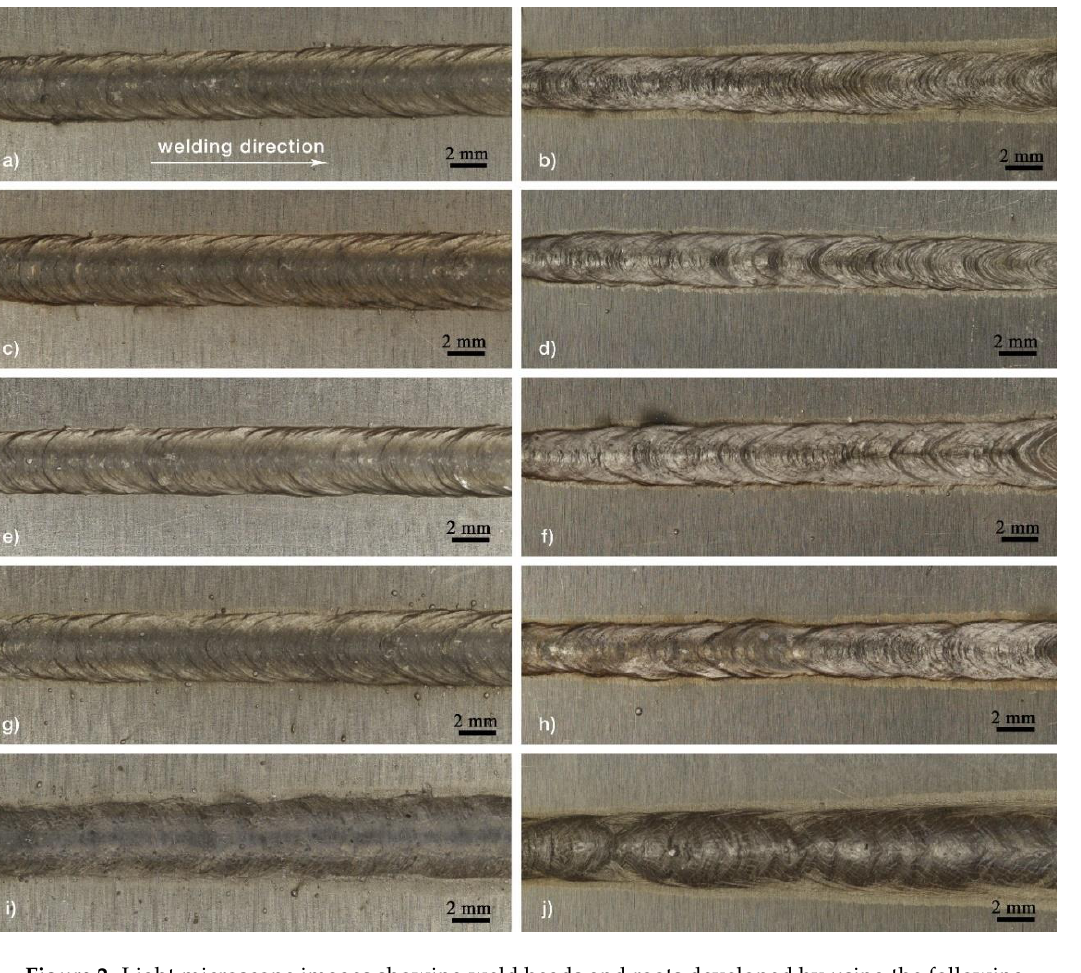
Figure 2. Light microscope images showing weld beads and roots developed by using the following gas flow rates (L/min): ( a , b ) 30; ( c , d ) 24; ( e , f ) 18; ( g , h ) 12; ( i , j ) 0. gas flow rates (L / min): ( a , b ) 30; ( c , d ) 24; ( e , f ) 18; ( g , h ) 12; ( i , j )